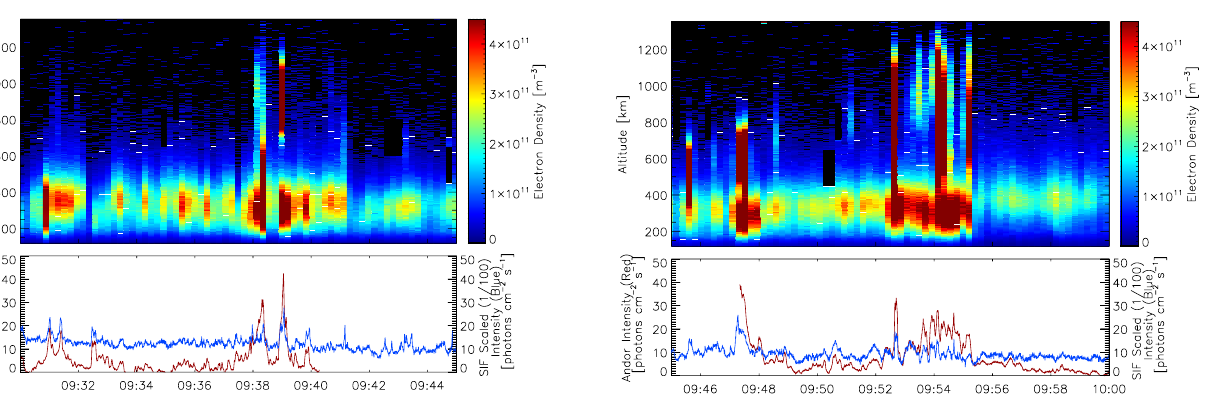
Fig. 5. As Fig. 4, for the interval